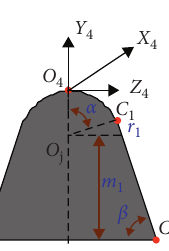
Figure 7: Type and coordinate definition of cutting head.